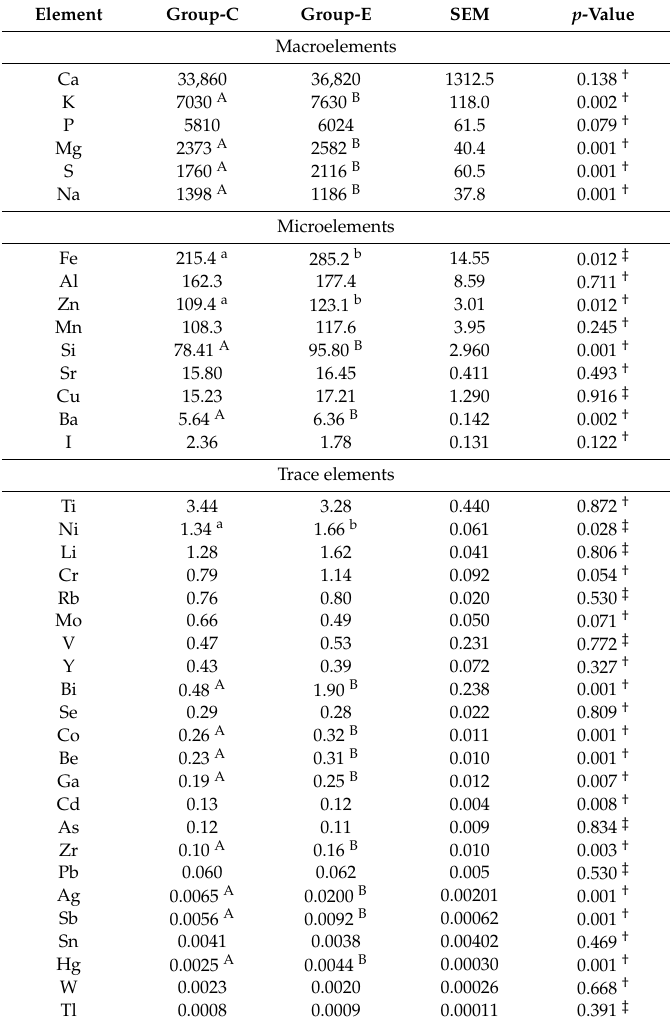
Table 2. The content of macroelements, microelements and trace elements in the feed mixture (mg / kg).